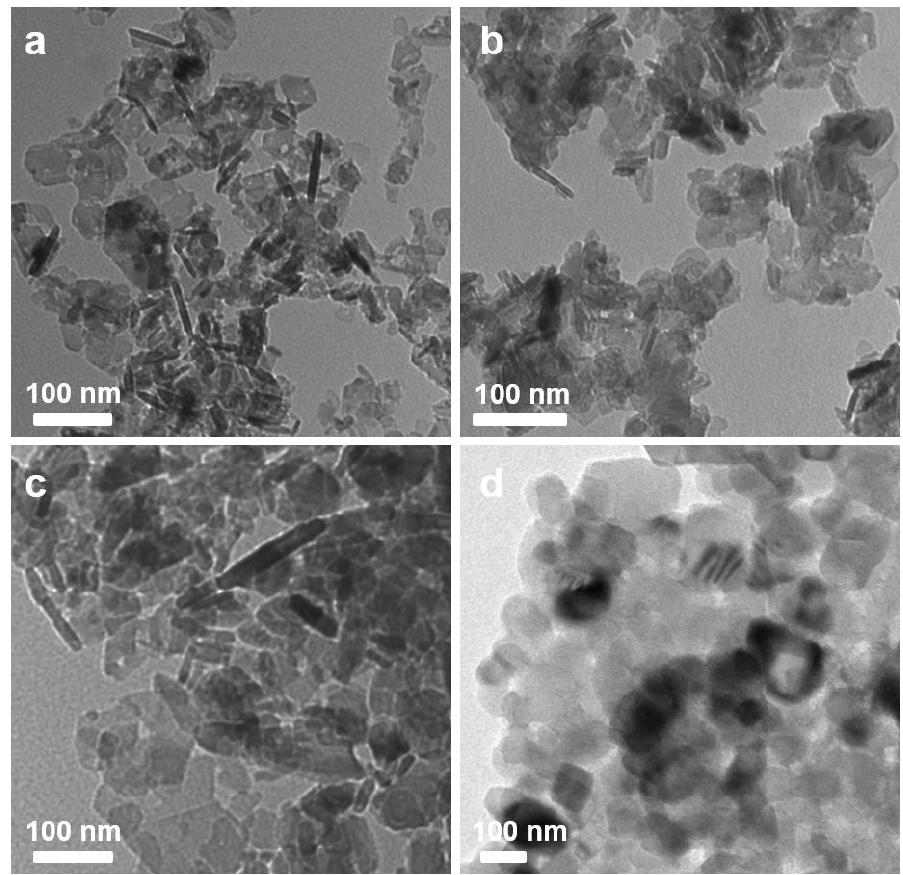
Figure 2. TEM images of Ni x Mg 1 − x O catalysts, ( a ) Ni 0.03 Mg 0.97 O, ( b ) Ni 0.1 Mg 0.9 O, ( c ) Ni 0.2 Mg 0.8 O, and ( d ) Ni 0.1 Mg 0.9 O-con.